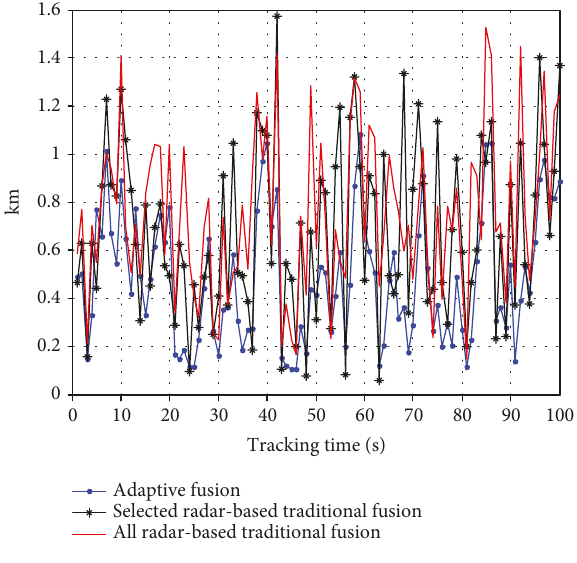
Figure 4: Range RMSE of X direction.